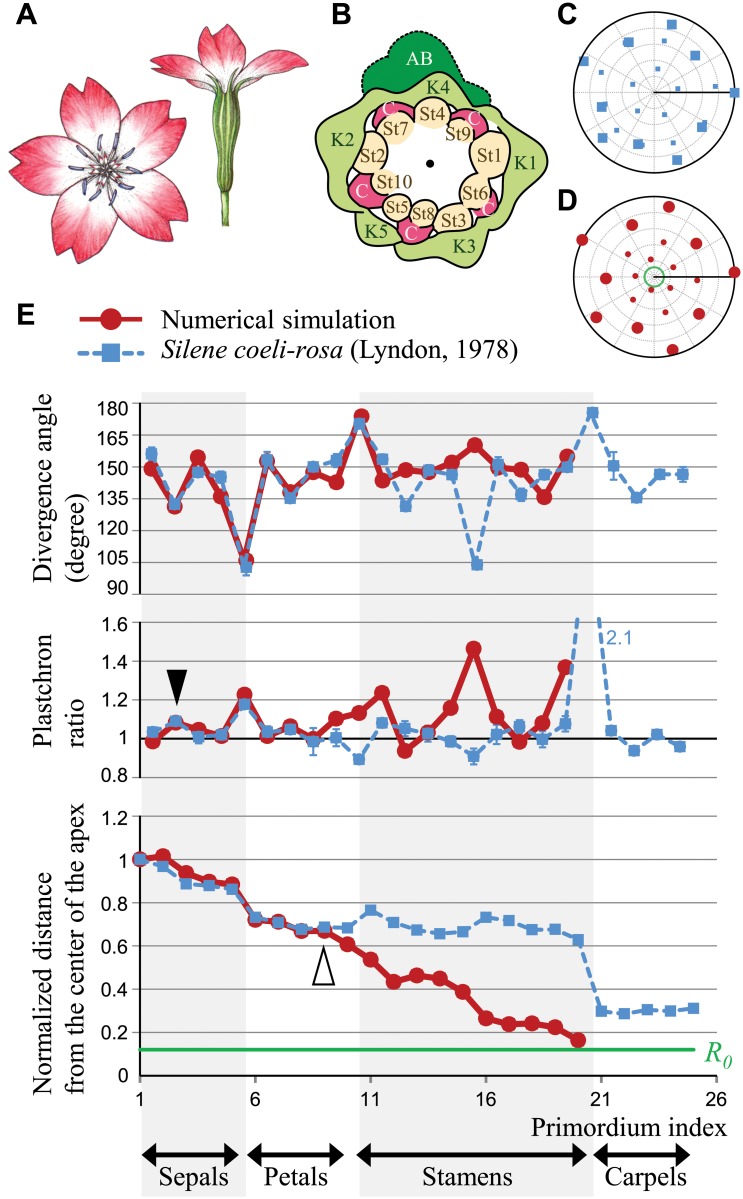
Reconstructing pentamerous floral development.
A. Flower of Silene coeli-rosa (Caryophyllaceae). B. Reproduction of the S. coeli-rosa floral meristem traced from an SEM image by Lyndon [34]; the colors were modified. Numbers indicate the initiation order. K (sepals), C (petals), St (stamens), AB (axillary bud). C. Average position of the S. coeli-rosa floral primordia reconstructed from the divergence angle and plastochron ratio (E) measured by Lyndon (Table 1 in [34]). The number of measured apices is 9 for sepals, 5 for petals, 7 for stamens, and 2 for carpels. The positions of sepals and petals are depicted in large squares, and those of stamens and carpels are depicted in small squares. D. Spatial pattern of the model simulation. The first ten primordia are shown by large circles, and the subsequent ten primordia are shown by small circles. τ = 600, R
0 = 30.0, α = 3.0, σ
r = 0.05, σ
θ = 5.0, λ
ini = λ
g = 20.0, P
MP = 0. E. Divergence angle (top panel) and plastochron ratio (middle) between two succeeding primordia, and the distance from the center of the apex (bottom panel) in S. coeli-rosa (blue squares) and in the model simulation (red circles). The order of petal initiation was estimated from that of the adjacent stamens (St6-St10 in B) following the experimental report [34]. The measurements agree with the model until the ninth primordium (open arrowhead). Error bars for the divergence angle and plastochron ratio of S. coeli-rosa denote the standard errors. Because the absolute values of the S. coeli-rosa primordia radii were not published, the distance from the center is normalized by the radius of the first sepal. The values of the parameters are the same as those in D. The green line (D and E bottom panel) indicates the meristem boundary in the simulation.